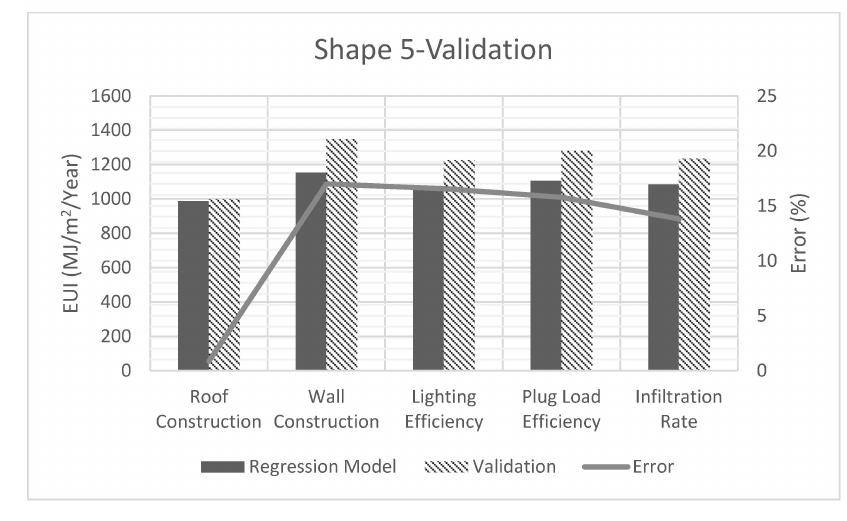
Figure 24. TETB Shape 5 validation.